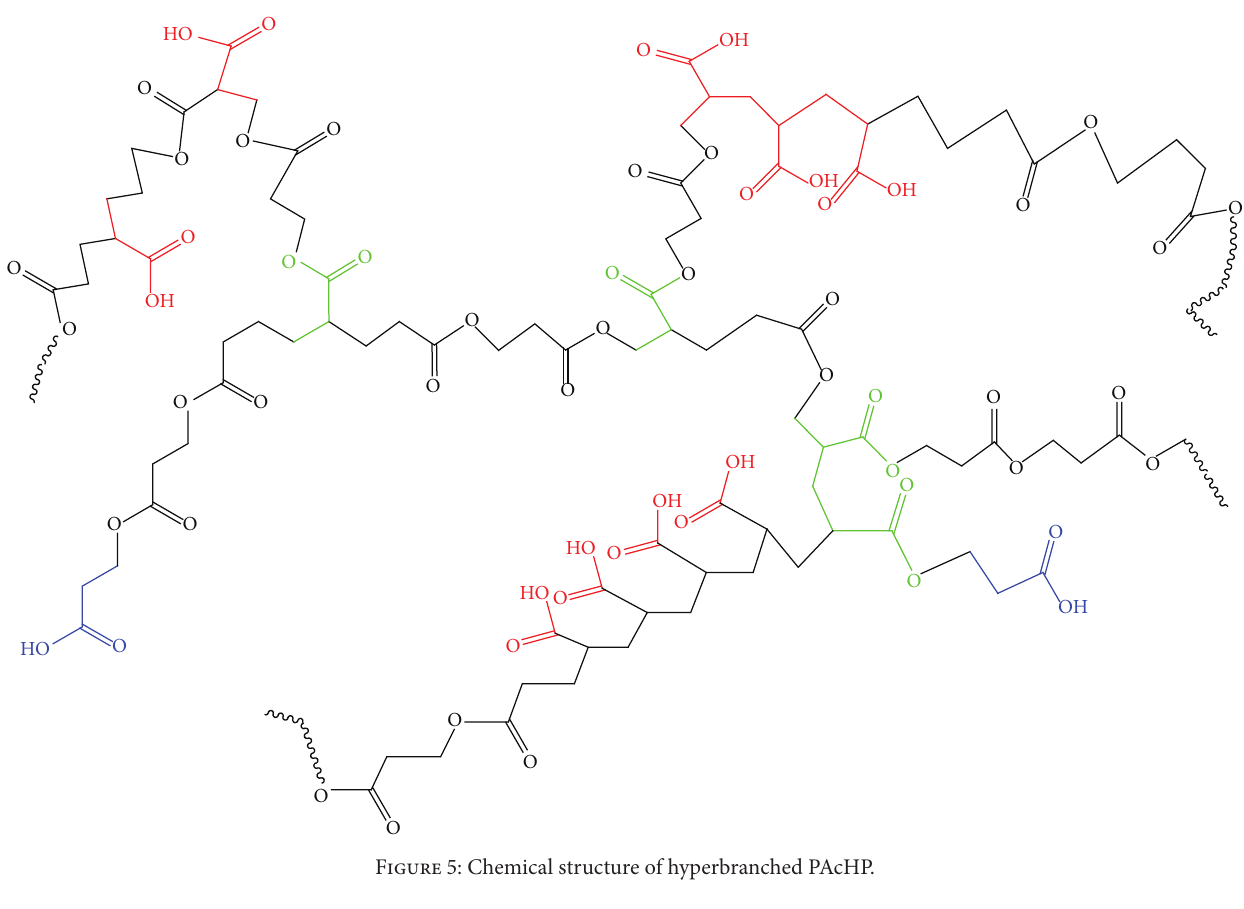
Figure 5: Chemical structure of hyperbranched PAcHP.